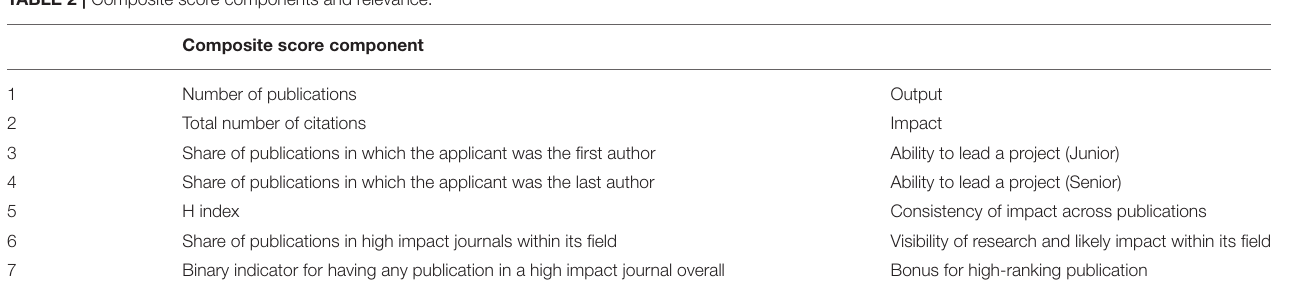
TABLE 2 | Composite score components and